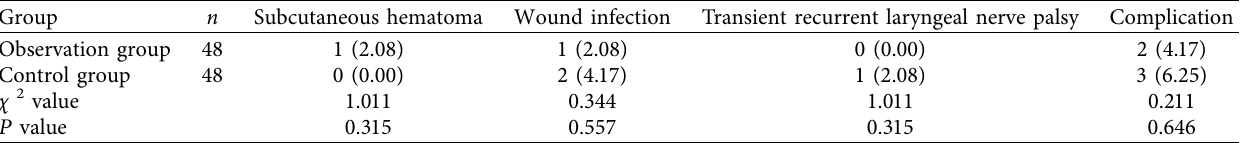
Table 5: Comparison of the incidence of complications between the two groups ( n ,